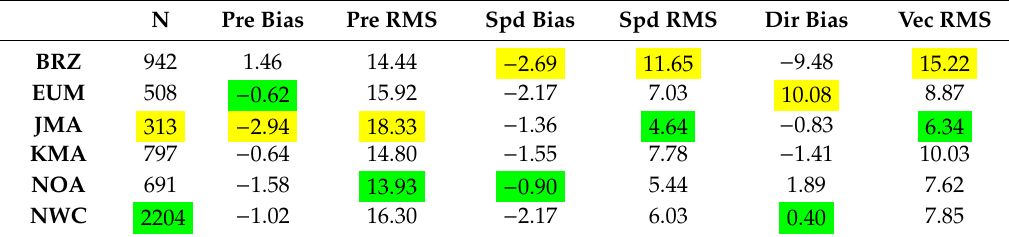
Table 11. Experiment 2: Comparison of AMVs, with CQI >= 50%, to radiosonde winds within 150 km. (N = Number of Matches; Pre Bias = Pressure Bias; Pre RMS = Pressure Root Mean Square Error; Spd Bias = Wind Speed Bias; Spd RMS = Wind Speed Root Mean Square Error; Dir Bias = Wind Direction Bias; Vec RMS = Wind Vector Root Mean Square Error). The extremes for each category are highlighted; in yellow, the worst value, and in green, the best value.